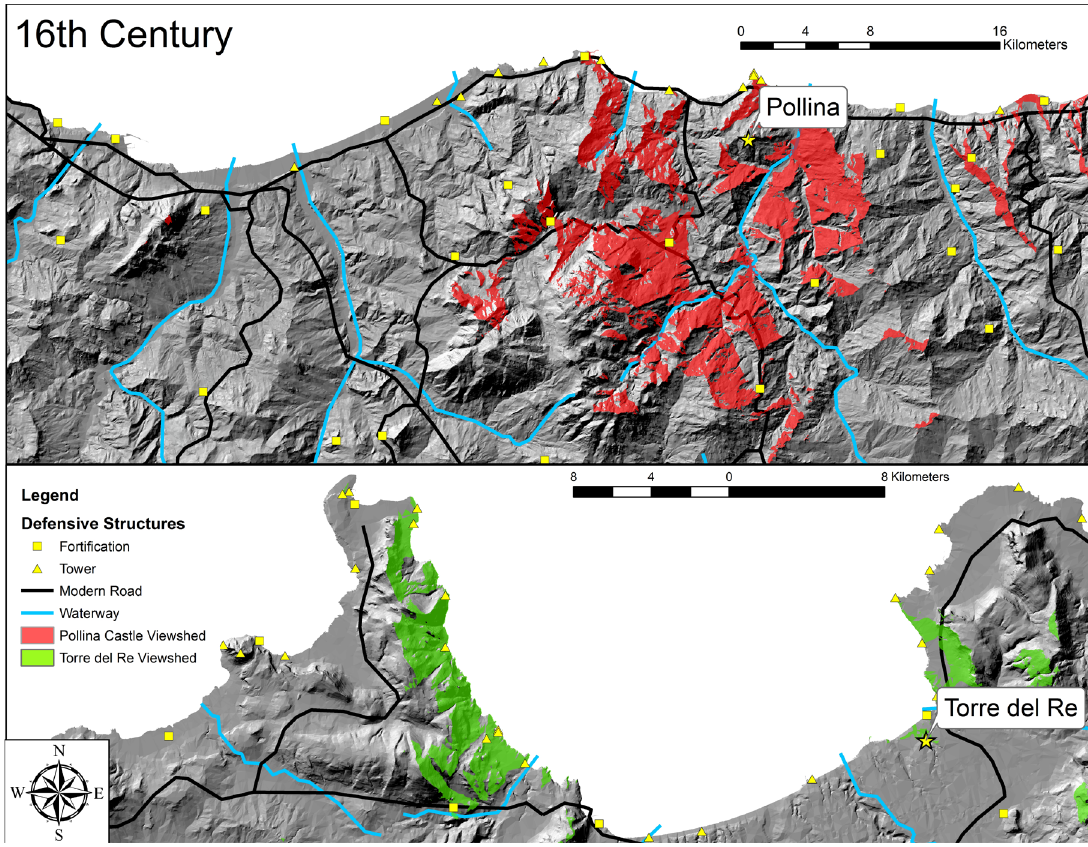
Figure 12. Figure showing the viewshed of the Castle of Pollina (top) and the Torre del Re (bottom) in the 16 th century. View- sheds derived from the Tarquini et al. (2007) 10m DEM of Sicily. Modern roads and waterways from Hijmans et al.